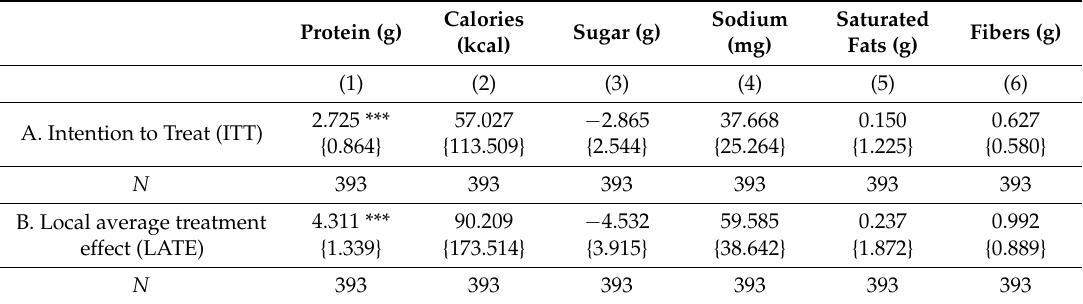
Figure 6. Nutritional content of purchases, by nutrient and randomization group, using a standardized serving size of 100 g or mL. Table 6. ITT and LATE effects of providing Nutri-Score Label information over nutritional content of bought items in a standardized serving size (100 g for solid or 100 mL for liquid), by nutrient.